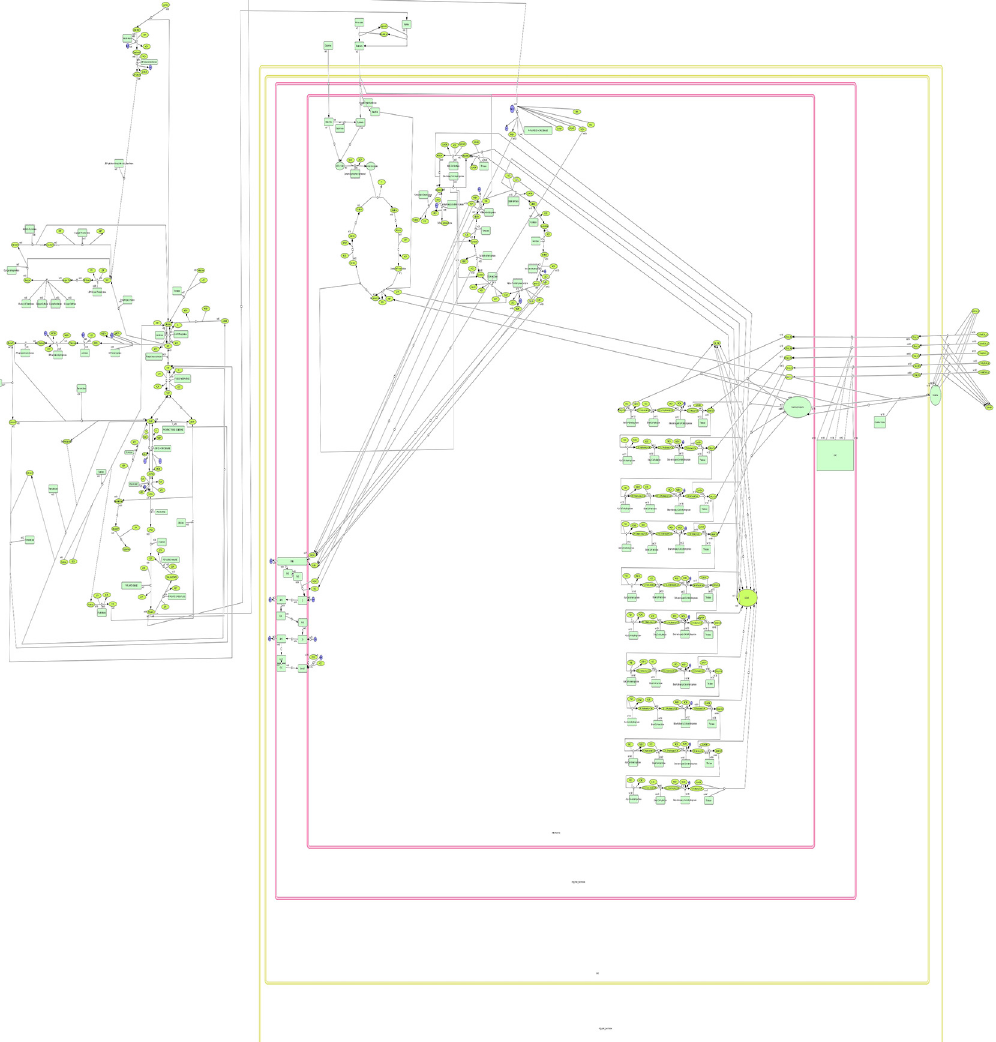
Fig 3. Symbols and Expressions used in CellDesigner by Kitano et al., 2007[21]. Dimensions and type of species in use plays a vital role in designing of complex metabolic networks. CellDesigner has a wide variety of notations to represent the species. There are state node symbols which represent for example a protein or a receptor. Also, there are the arc symbols which are the transit nodes and edges. Further each node has a different node structure depending on the reaction. One advantage of CellDesigner is its view only reduced notation. doi:10.1371/journal.pone.0127918.g003 PLOS ONE | DOI:10.1371/journal.pone.0127918 June 8,